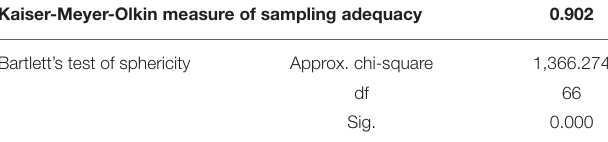
TABLE 2 | KMO and Bartlett sphere test.